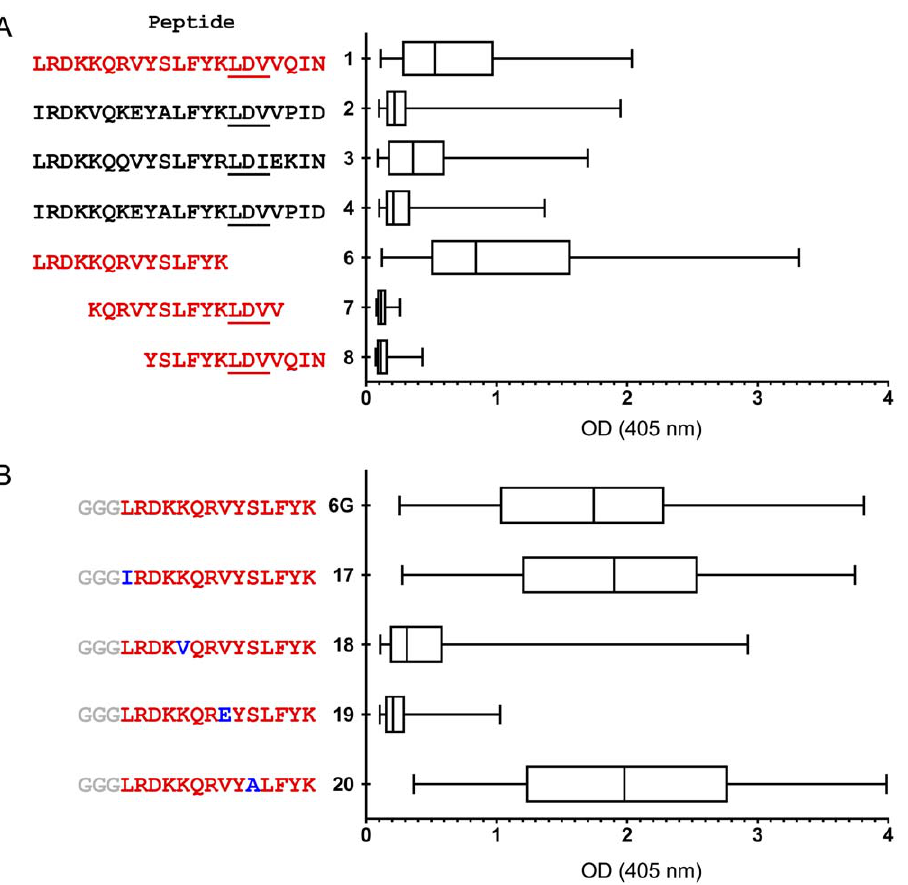
Figure 5. Boxplots showing ELISA reactivity of V2 peptides with plasma (diluted 1:100) from 80 vaccinees’ specimens from the pilot study (Set C). The distributions of the reactivities are shown where the left edge of each box equals the 25th percentile; the vertical line in each box is the 50th percentile, and the right edge of each box equals the 75th percentile. The boxplots were prepared using Prism, with ‘‘whiskers’’ showing the minimum and maximum responses. Panel A: Four 21-mer N-terminal biotinylated peptides (Peptides 1–4) were selected on the basis of a bioinformatics analysis of V2 sequences from the LANL HIV Database (see text). Panel B: A second peptide panel designed upon inspection of the AAs in Peptides 1–4 in Panel A revealed AAs that distinguish Peptides 1 and 3 from 2 and 4; these appear at positions 165, 169, 172, and 174. To maximally enhance the availability of the epitopes on the peptides used in the fine mapping of the V2 Abs, a spacer of three glycines was inserted between the biotin tag at the N-terminus of the peptide and the V2